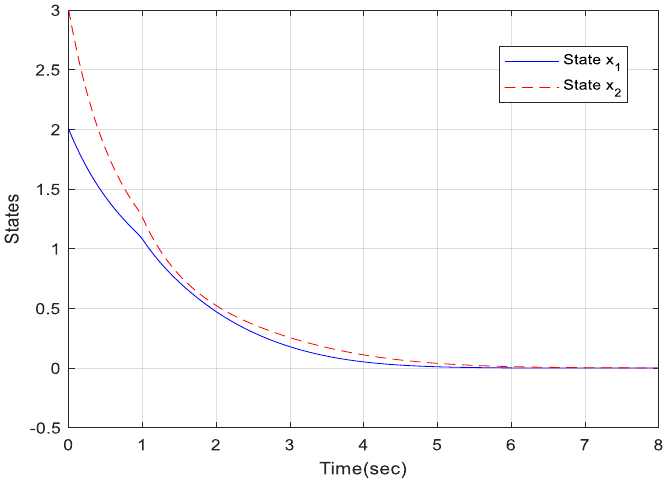
Figure 1. Trajectories for 𝑥 1 and 𝑥 2 .